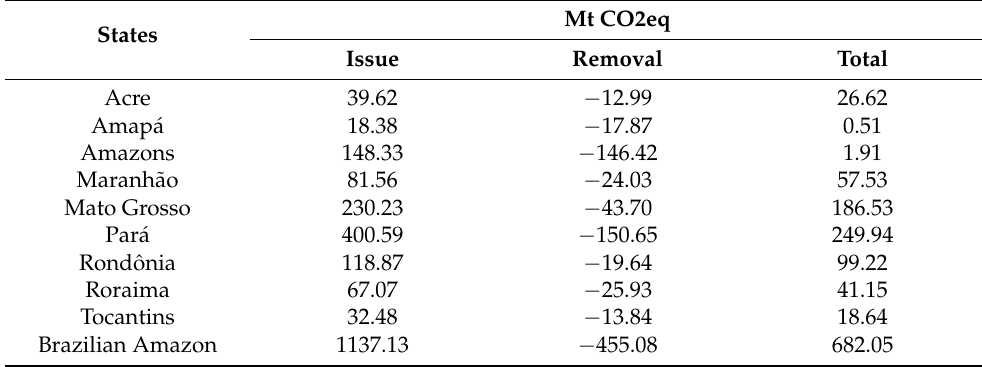
Table 11. GHG emission and removal in the states of the Brazilian Amazon in 2019. Source: [21].